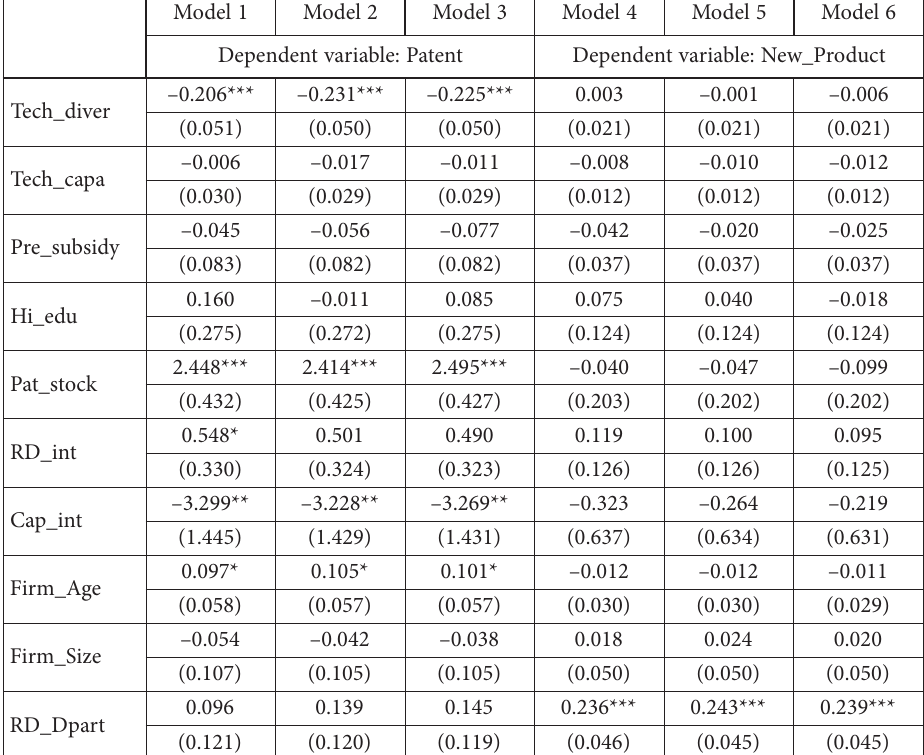
Table 3. The impacts of direct R&D grants and subsidized loans on R&D